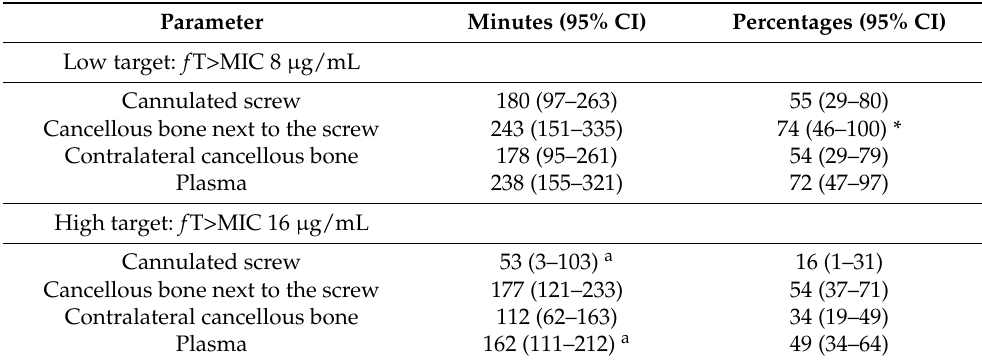
Table 1. Mean time above the low and high target MIC for piperacillin presented in percentages and minutes in the third dosing interval (steady-state